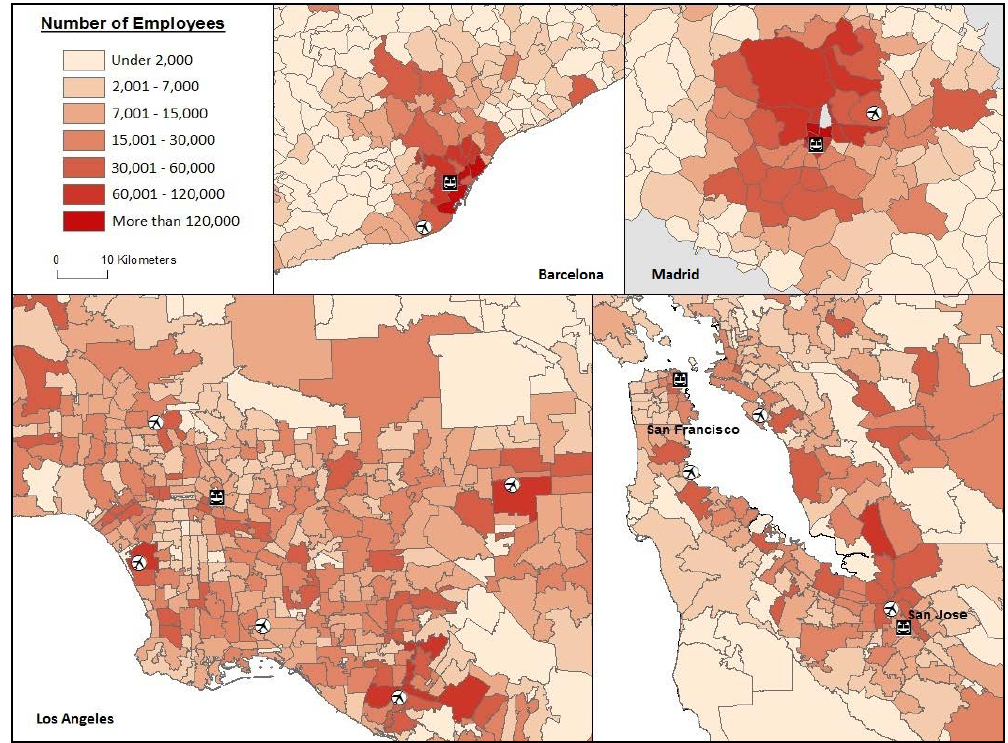
Figure 3 Employment Comparisons 1: Barcelona, Madrid, Los Angeles and San Francisco Bay Area